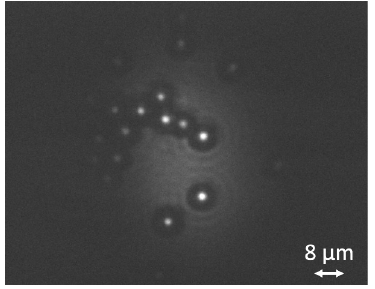
Figure 2. Wide-Field CARS image of 8- µ m Polystyrene (PS) beads in a so- lution of Dimethyl sulfoxide (DMSO). 460x540 pixels, 2ms integration